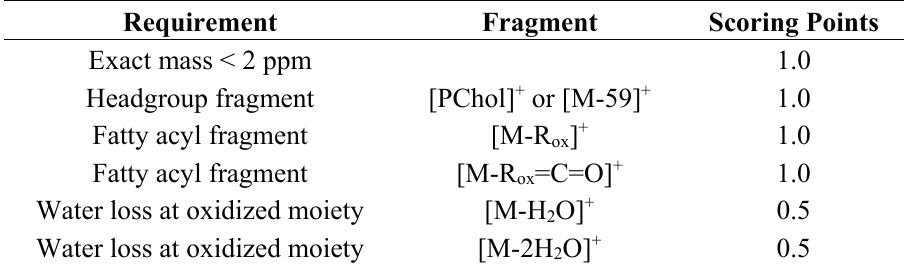
Table 1. Presented scoring scheme to estimate the reliability of a hit.